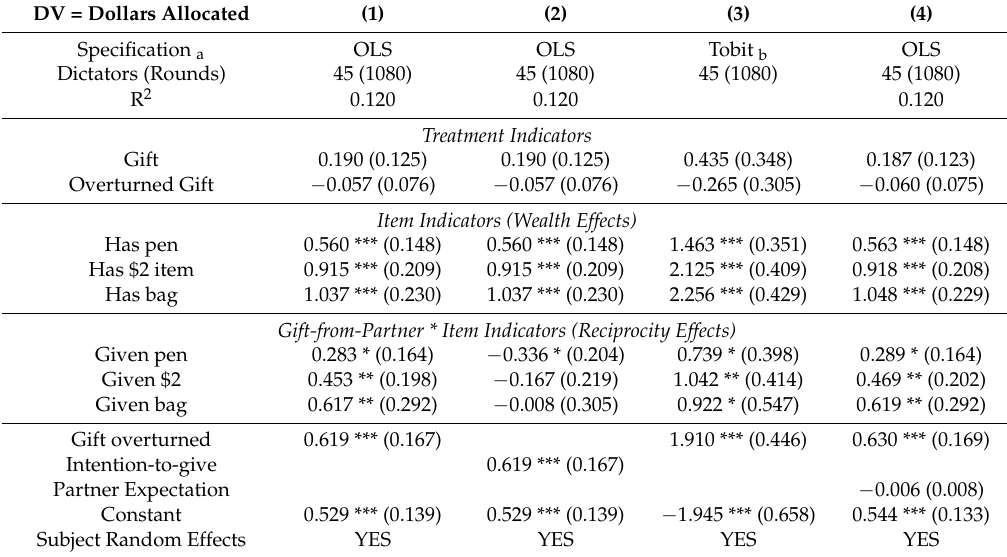
Table 1. Allocation by Type of Gift